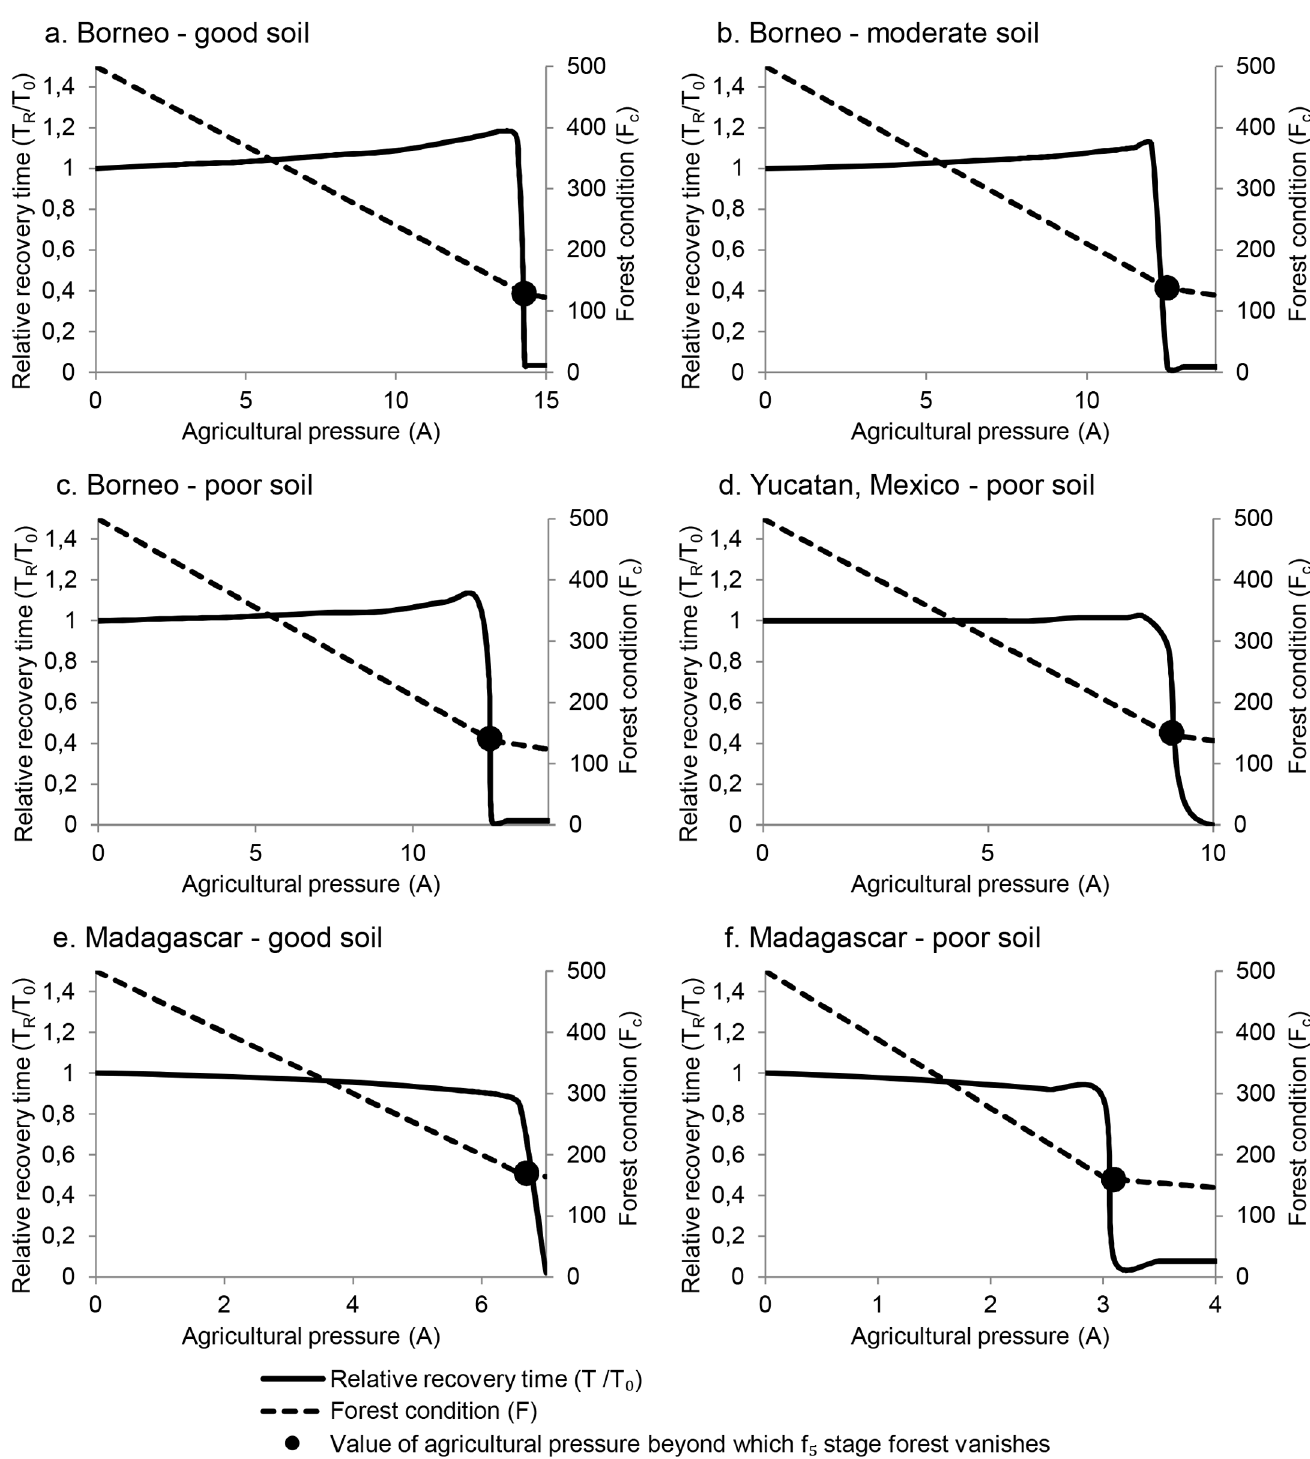
Fig 7. Relative recovery time following a standardized disturbance as a function of agricultural pressure. Note that this value is not an absolute number of time steps as in our definition of engineering resilience, but is scaled to the recovery time in the absence of agricultural pressure for easy comparison among the cases. The level of agricultural pressure at which f 5 stage forest is no longer possible depends on the values of the forest recruitment rate and succession parameters. These plots are for a local recruitment rate ( r ) of 0.3; plots for r = 0.5 were virtually identical.